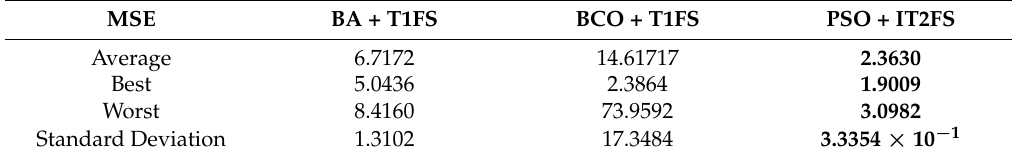
Table 15. Comparison of best methods applied to the plant with